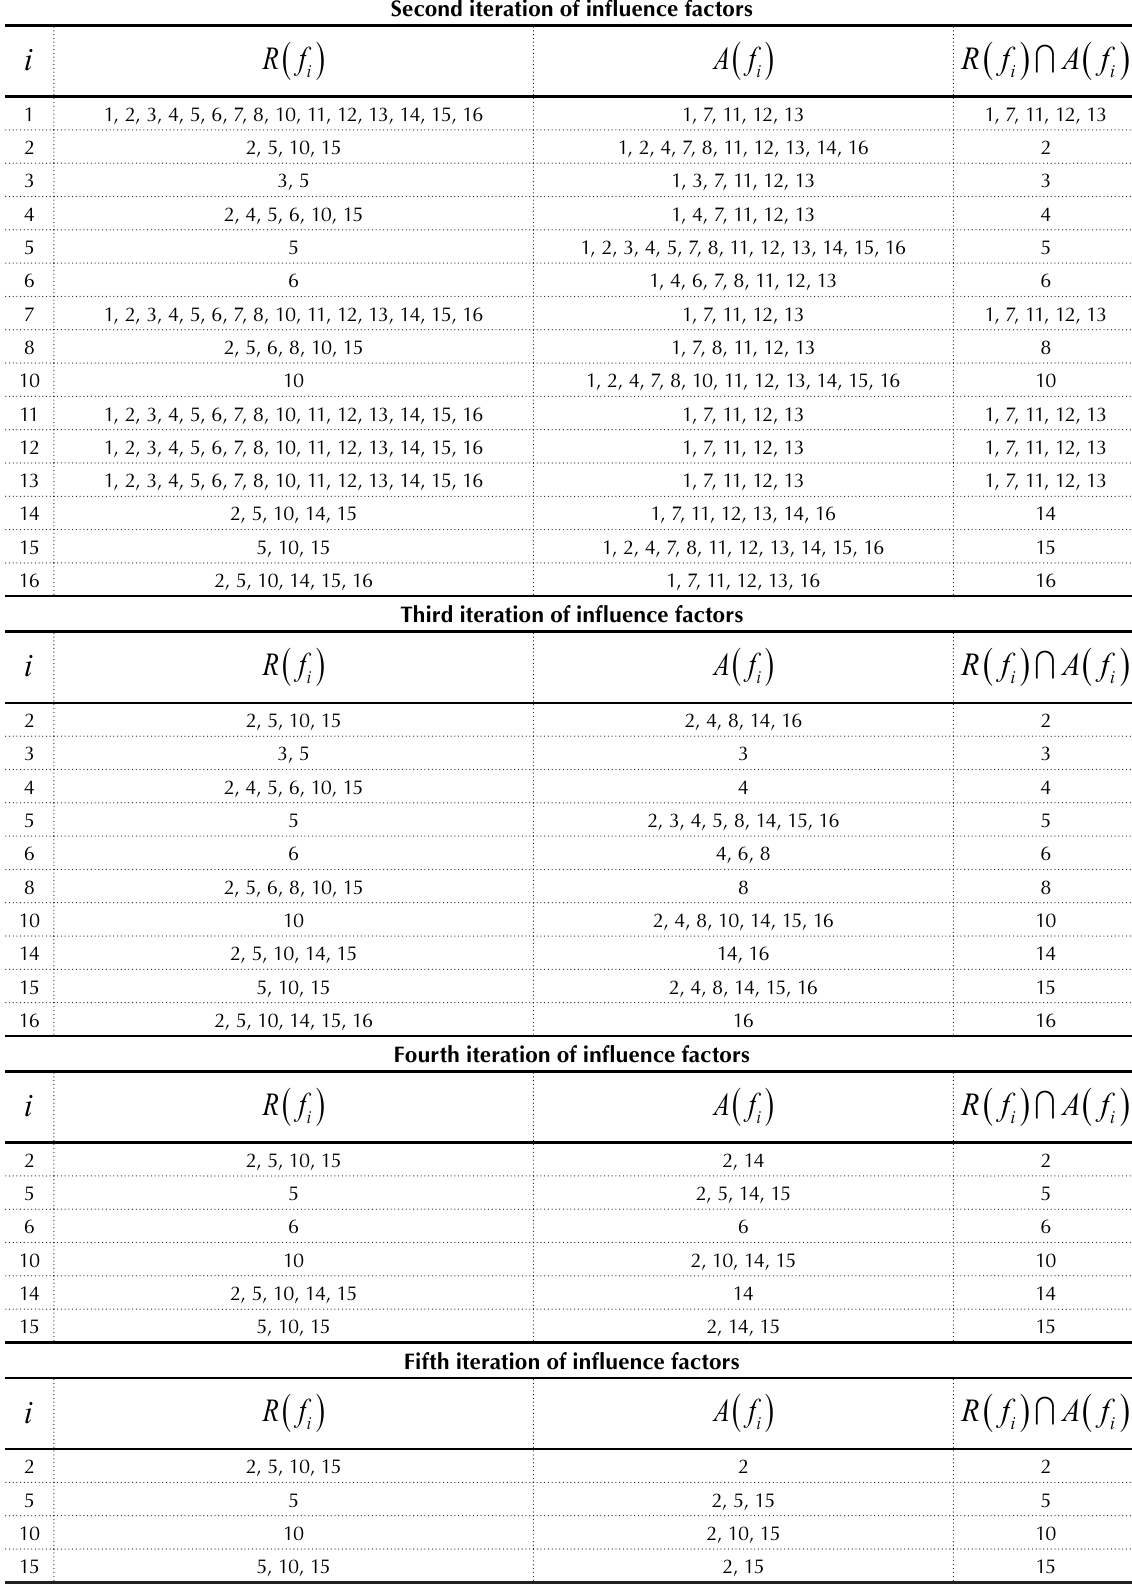
Table 2 (cont.). Sequence of iterations determining the hierarchy levels of factors influencing the energy security of the enterprise Second iteration of influence